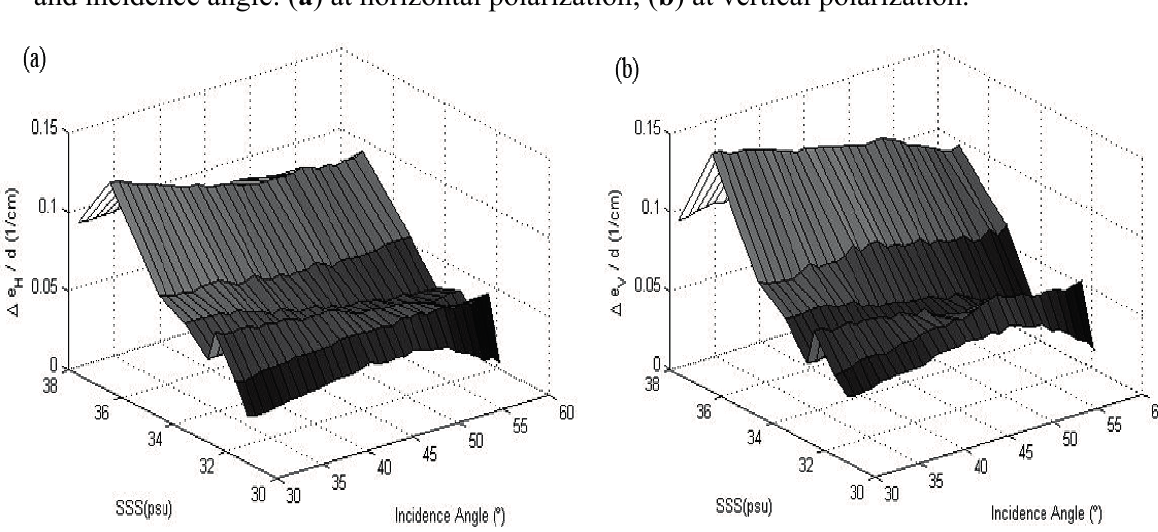
Δ for foam thickness 1 cm, varying with SSS e VH ,